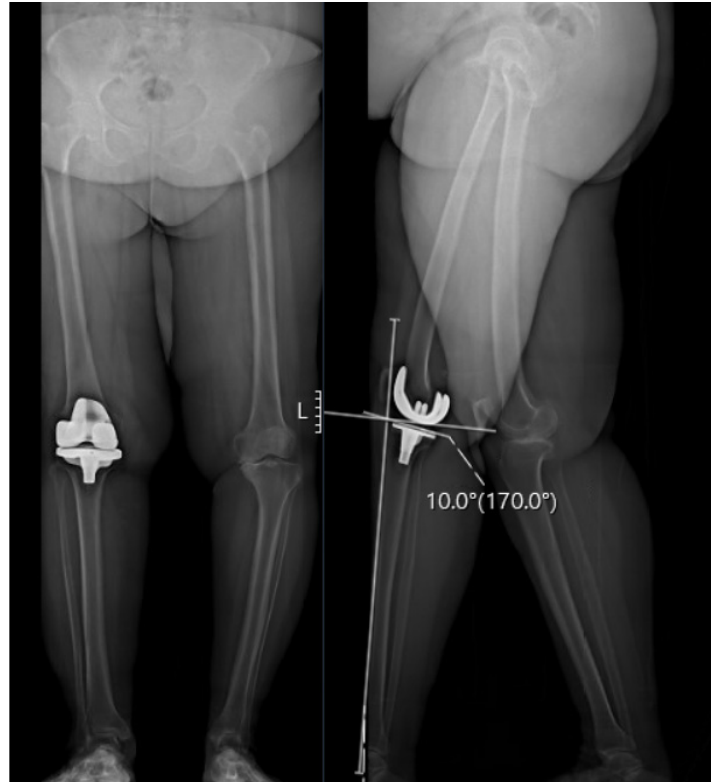
Figure 1. A 73 ‐ year ‐ old female with a postoperative PTS of 10°, an MPTA of 81°and an LDFA of 84°. Preoperative VAS was 9, OKS was 20 and overall KOOS was 52 (symptoms 13, pain 32, function 41 and QOL 28). Postoperative scores improved to a VAS of 2, OKS of 45, and overall KOOS of 81 (symptoms 75, pain 89, function 81 and QOL 75) at 2.4 years following surgery.